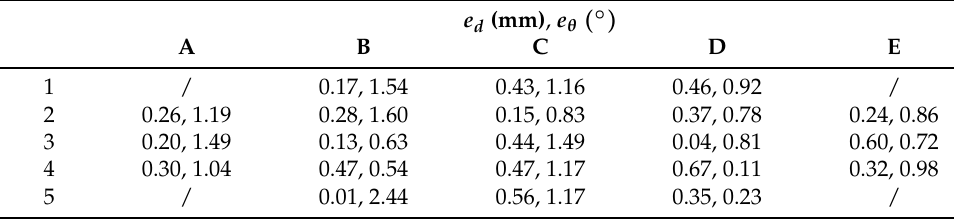
Table 3. Results of the experiments on validation of hand-eye calibration.